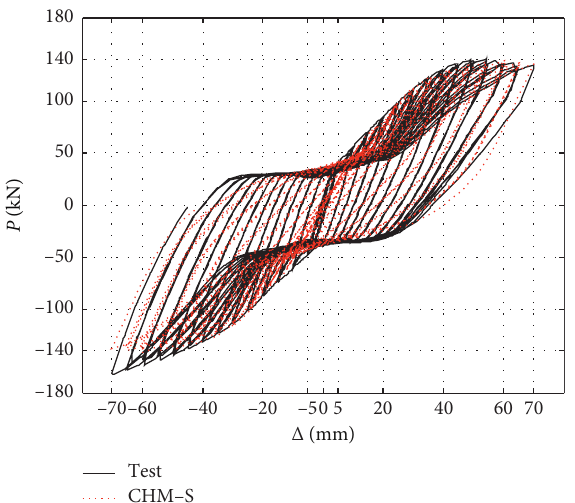
Figure 16: Comparison between the hysteresis curves from the experiment and that of CHM-S.